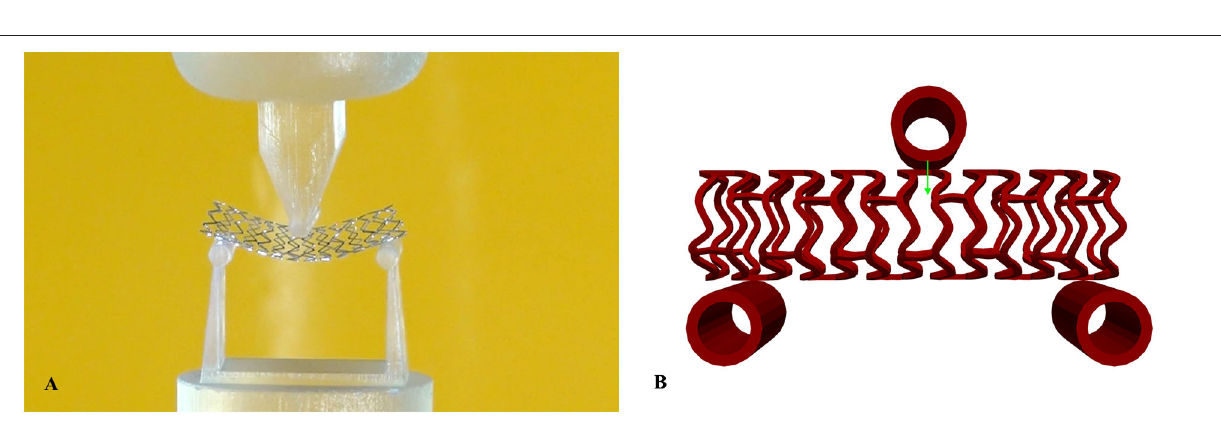
FIGURE 9 | Three-point bending test: experimental set up (A) , and boundary conditions (B) .